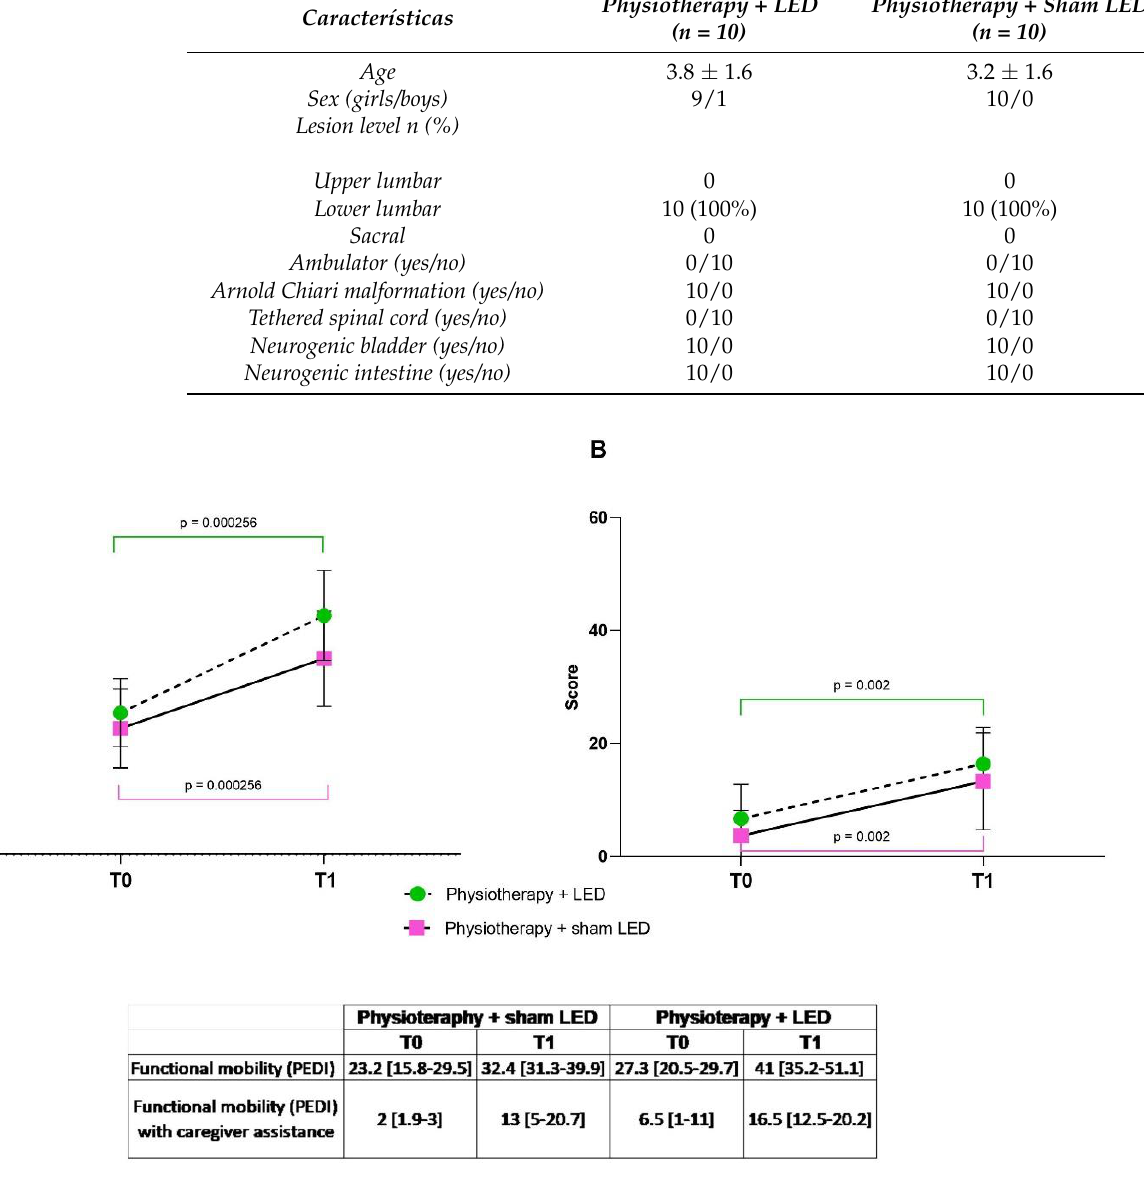
Figure 4. PEDI scores without ( A ) and with caregiver assistance ( B ) — T0: pre-intervention; T1: after 24 sessions. Data expressed as median and interquartile range. ** p <